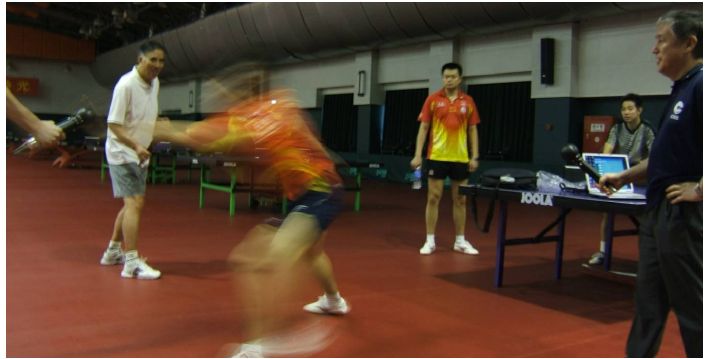
Figure 4. National table tennis players are carrying out footwork testing.